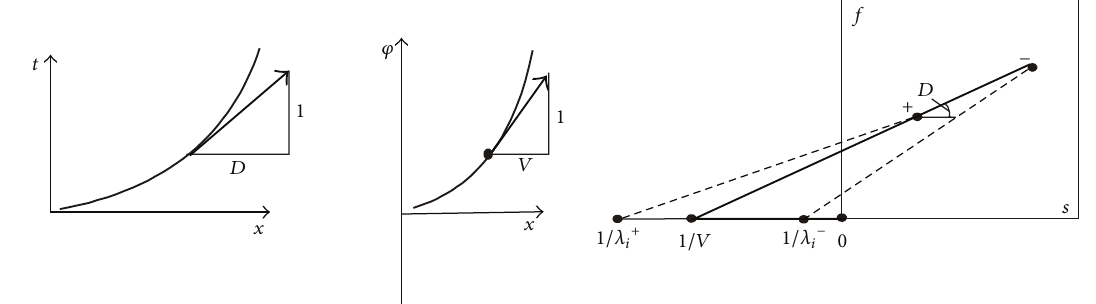
Figure 4: Speeds of a particle in Eulerian and Lagrangian